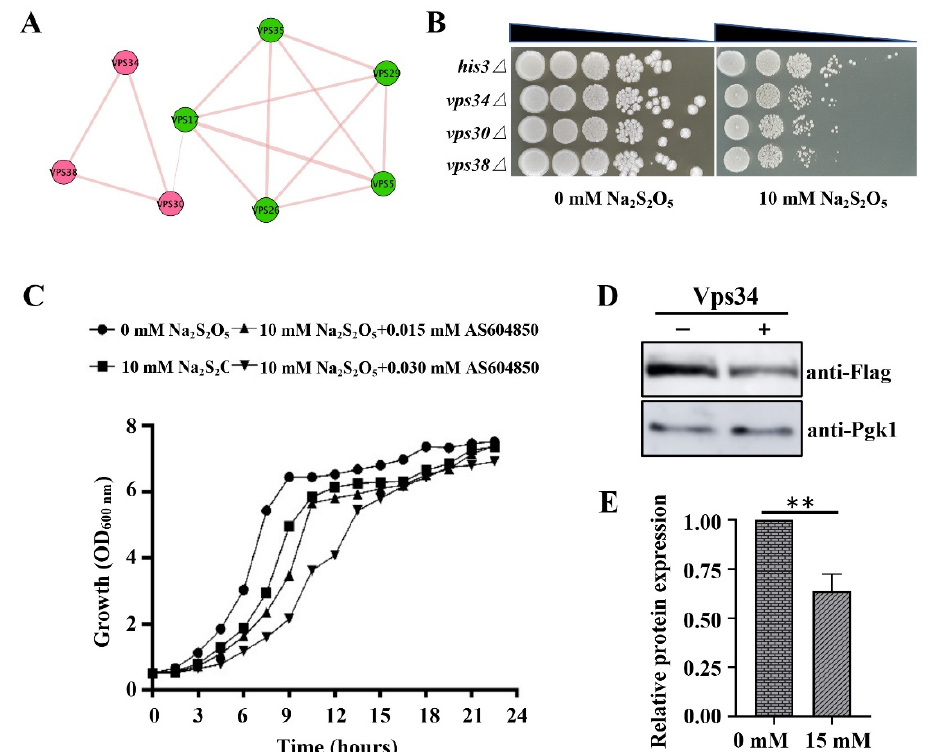
Figure 3. PI3K complex II-related proteins mediate the yeast sodium metabisulfite resistance response. ( A ) Physical interaction between the retromer complex and PI3K complex II. ( B ) Spot test assays of the SGA control strain ( MATa his3 ∆ ::kanMX4 ) and PI3K complex II-related gene deletion mutants. ( C ) Growth curve of yeast cells cultivated in different media. ( D ) Western bolt analysis of Vps34 expression before and after 15 mM Na 2 S 2 O 5 treatment (3 h). Pgk1 served as the loading control. ( E ) Accumulation levels of Vps34 were quantified using ImageJ software. Error bars indicate standard error. **, p < 0.01, Student’s t -test.